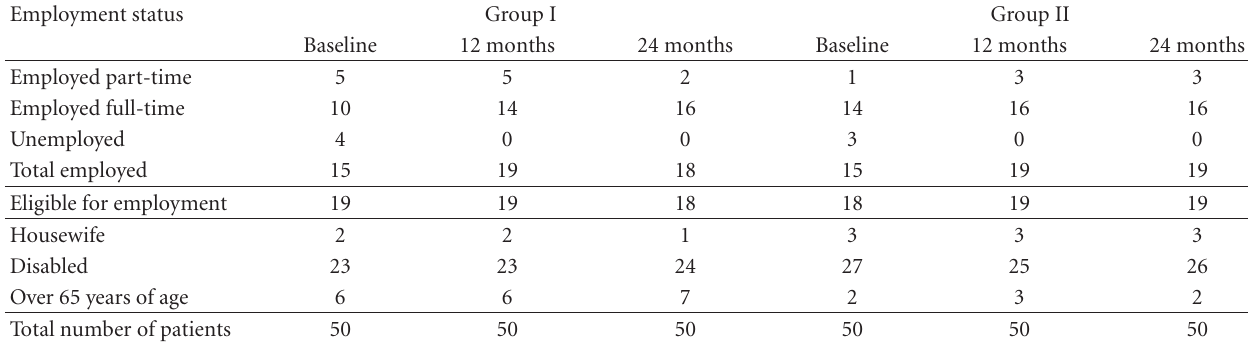
Table 4: Employment characteristics.